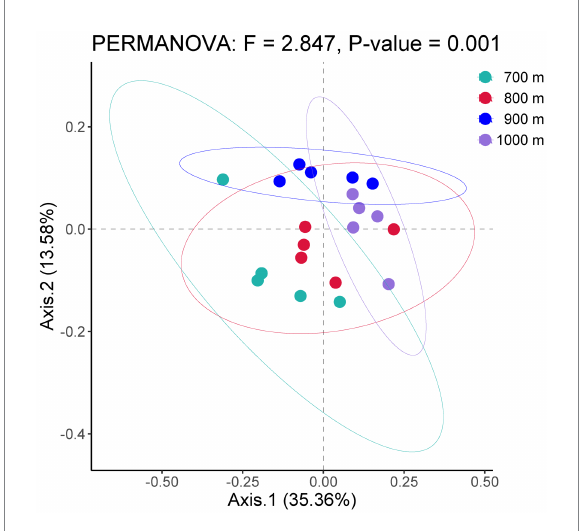
FIGURE 1 Principal coordinates analysis of bacterial communities in the soil at four altitudes with similar vegetation cover in Changbai Mountains, Northeastern